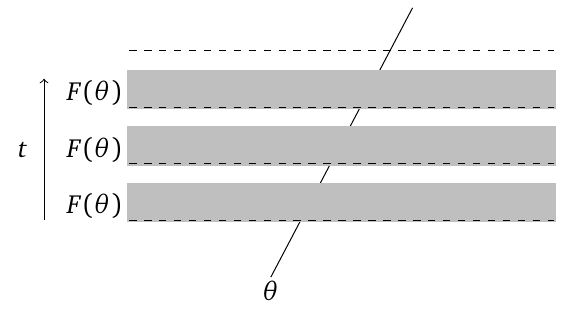
Figure 6: A particle propagating under an integrable Floquet Hamiltonian corre- sponding to the protocol Eq. (10). When measured stroboscopically, the particle rapidity is conserved. The effect of driving is only that the particle time evolution acquires a factor of F ( θ ) with every period, here represented as crossing through shaded region. The exact particle content and details of the dynamics within the shaded region are